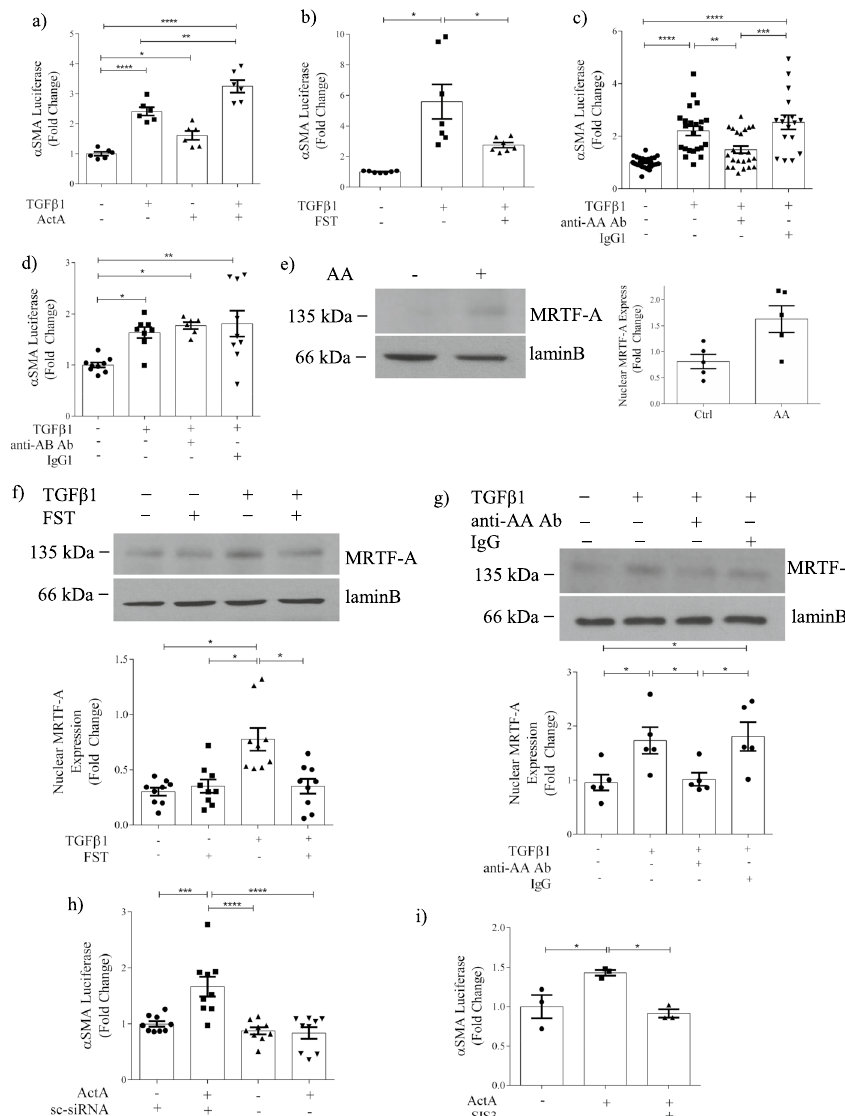
Fig. 5 Activin A regulation of MRTF-A contributes to αSMA induction by TGFβ1 in MC. a ActA (20 ng/ml) and TGFβ1 show an additive effect on αSMA promoter transcriptional activation at 24 h (n inhibition with b follistatin (n 7) and c an actA neutralizing antibody decrease TGFβ1-induced αSMA = promoter transcriptional activity (n 14–23). d actB neutralization does not decrease TGFβ1-induced αSMA = promoter transcriptional activity (n 6–9). e actA increases MRTF-A nuclear localization at 18 h (n = TGFβ1-induced nuclear MRTF-A translocation is attenuated with f follistatin (n (n 5). h ActA-induced αSMA promoter transcriptional activity is inhibited by MRTF-A siRNA (n = Smad3 inhibitor SIS3 (n 3). *, **, ***, **** P < 0.05, 0.01, 0.001, 0.0001; one-way ANOVA with Tukey’s multiple = comparisons post hoc